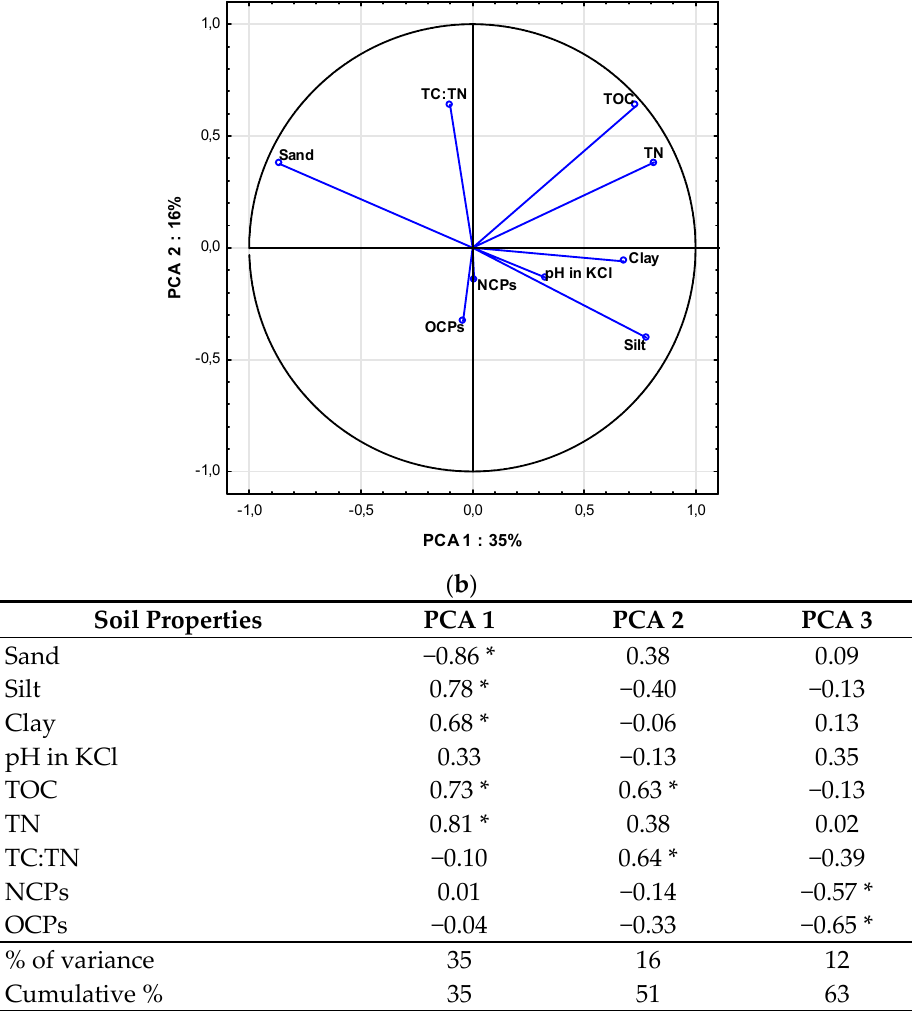
Figure 1. ( a ) Principal Component Analysis (PCA) ordination biplot (PCA 1 vs. PCA 2), eigenvectors of correlation matrix used to generate PCA components of soils contaminated by OCPs and NCPs pesticides, and seven measured soil variables for all data sets ( n = 216). Arrows/lines in biplot represent variable loadings relative to each component. ( b ) Factor loading matrix; loading ≥ 0.5 in bold.